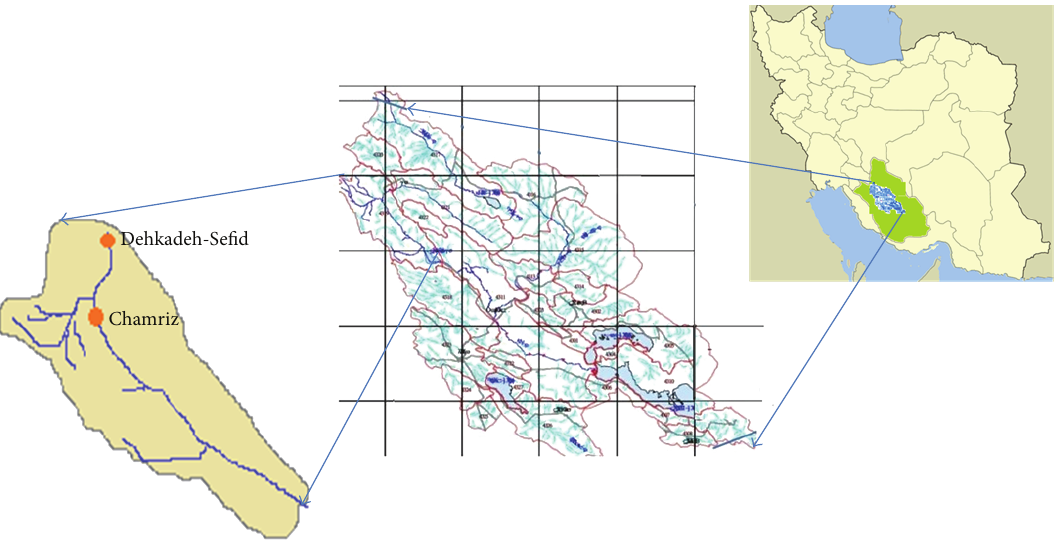
Figure 1: Location of two hydrometric stations on Kor River in Maharloo-Bakhtegan basin of